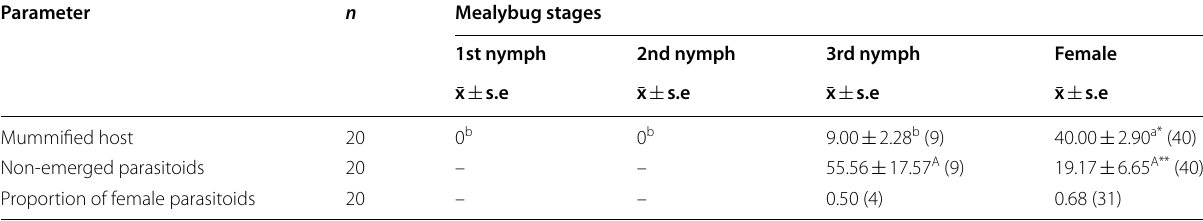
Figures under n indicate number of experimental wasps. Numbers in parentheses indicate total numbers * Means within a row followed by different lowercase letters are significantly different (Dunn–Bonferroni, P ** Means within a row followed by different uppercase letters are significantly different (Wilcoxon signed rank test, P Table 4 The developmental period of female (d), the developmental period of male (d), and preadult mortality rate of Leptomastix dactylopii